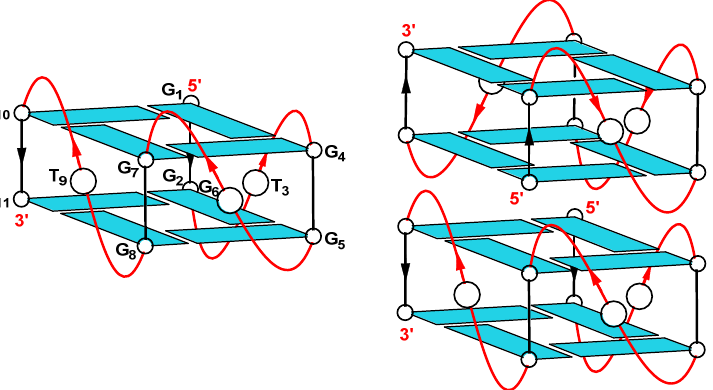
Figure 8. Schematic representation of the proposed parallel-stranded G-quadruplex structures, monomer ( left ) and head-to-head dimer ( right ), adopted by the 11-mer aptamer (5 ′ -GGTGGGGGTGG-3 ′ ).